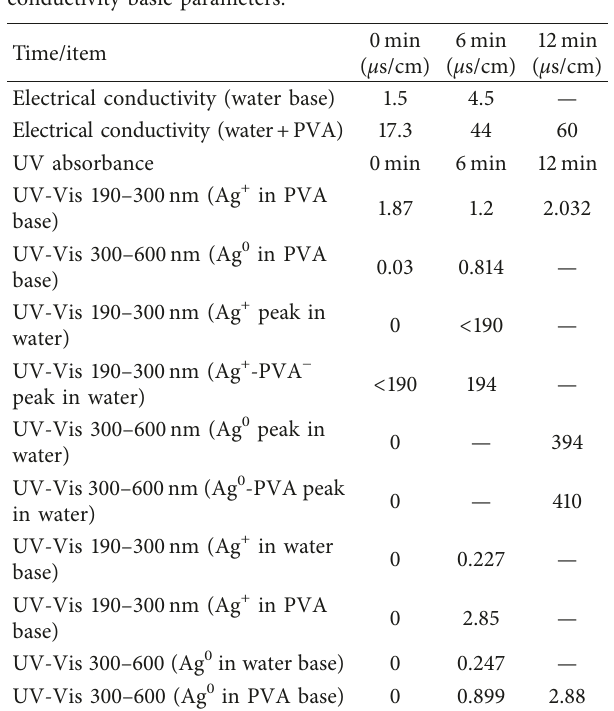
Table 3: 2.3 μ s/cm (DW) versus 20 μ s/cm (with PVA) electrical conductivity basic